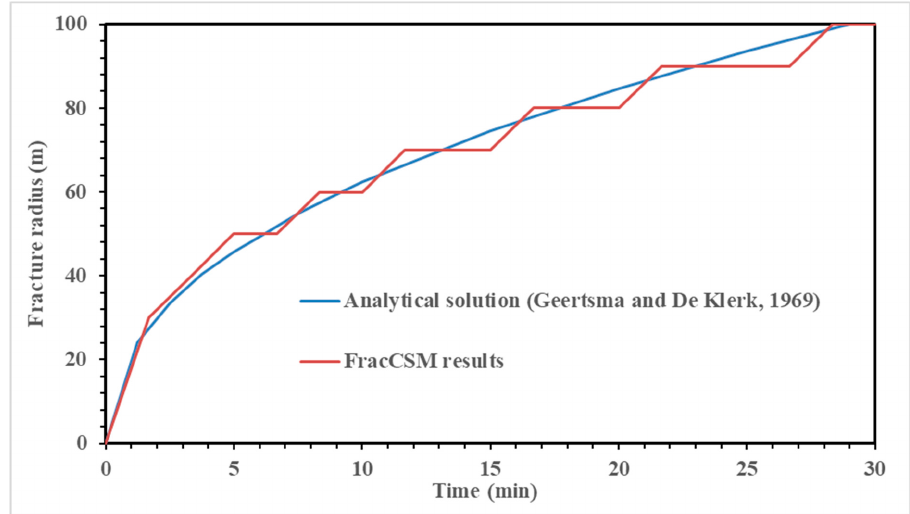
Figure 8. Comparison between simulation and analytical solution [3] for fracture radius versus time.